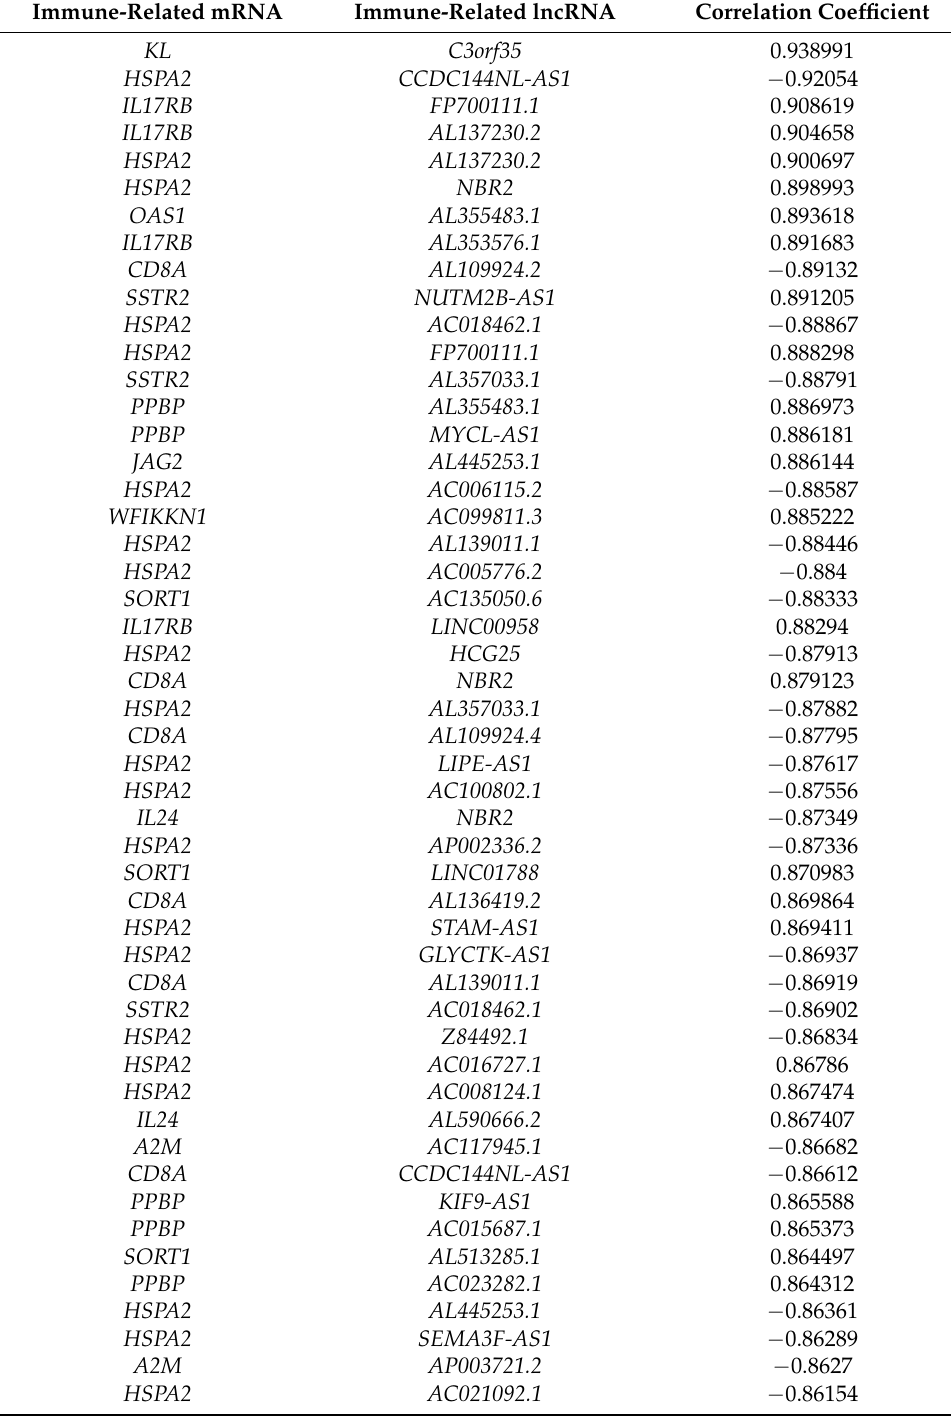
Table 1. Top 50 lncRNA–mRNA pairs in the co-expression